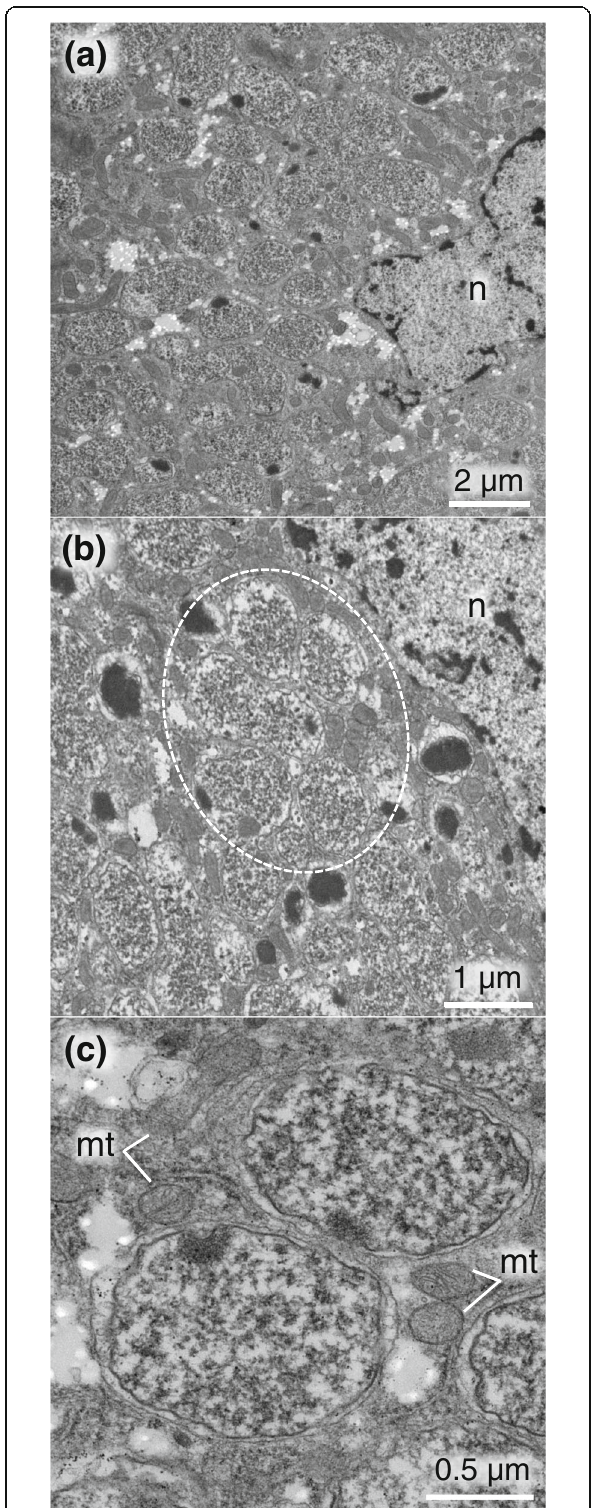
Fig. 5 Transmission electron microscopic images of symbiotic bacteria of R. dominica . a A low magnification image of symbiotic bacteria in a bacteriocyte. b A rosette-like cluster of symbiont cells highlighted by a dotted circle. c A magnified image of symbiont cells. Abbreviations: n, nucleus; mt,